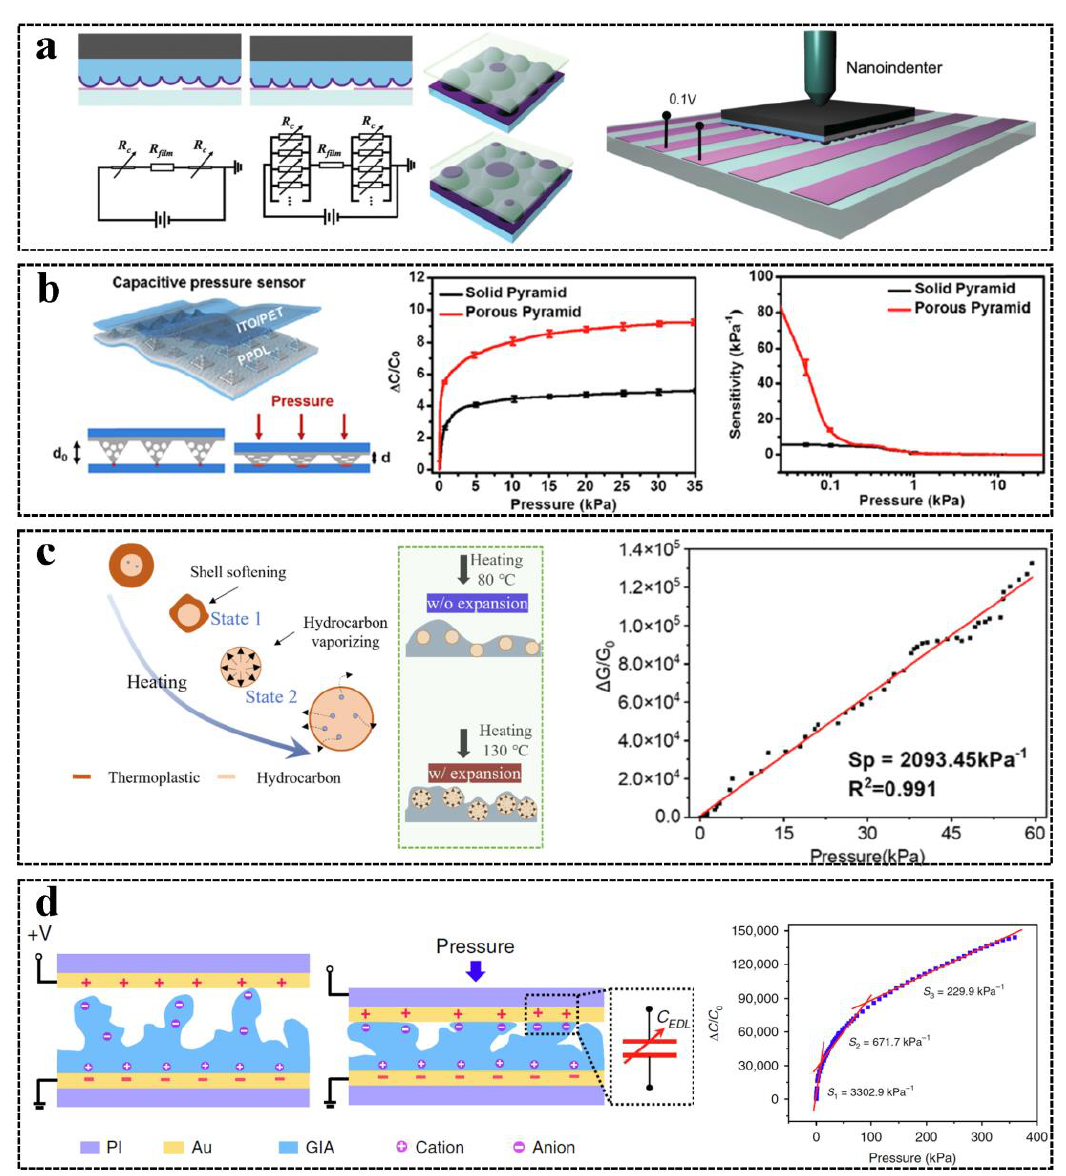
Figure 3. Strategies of tactile and force sensors to increase sensitivity: ( a ) A resistive pressure sensor with irregular surface microstructure enhances the sensitivity. Reproduced with permission [91],